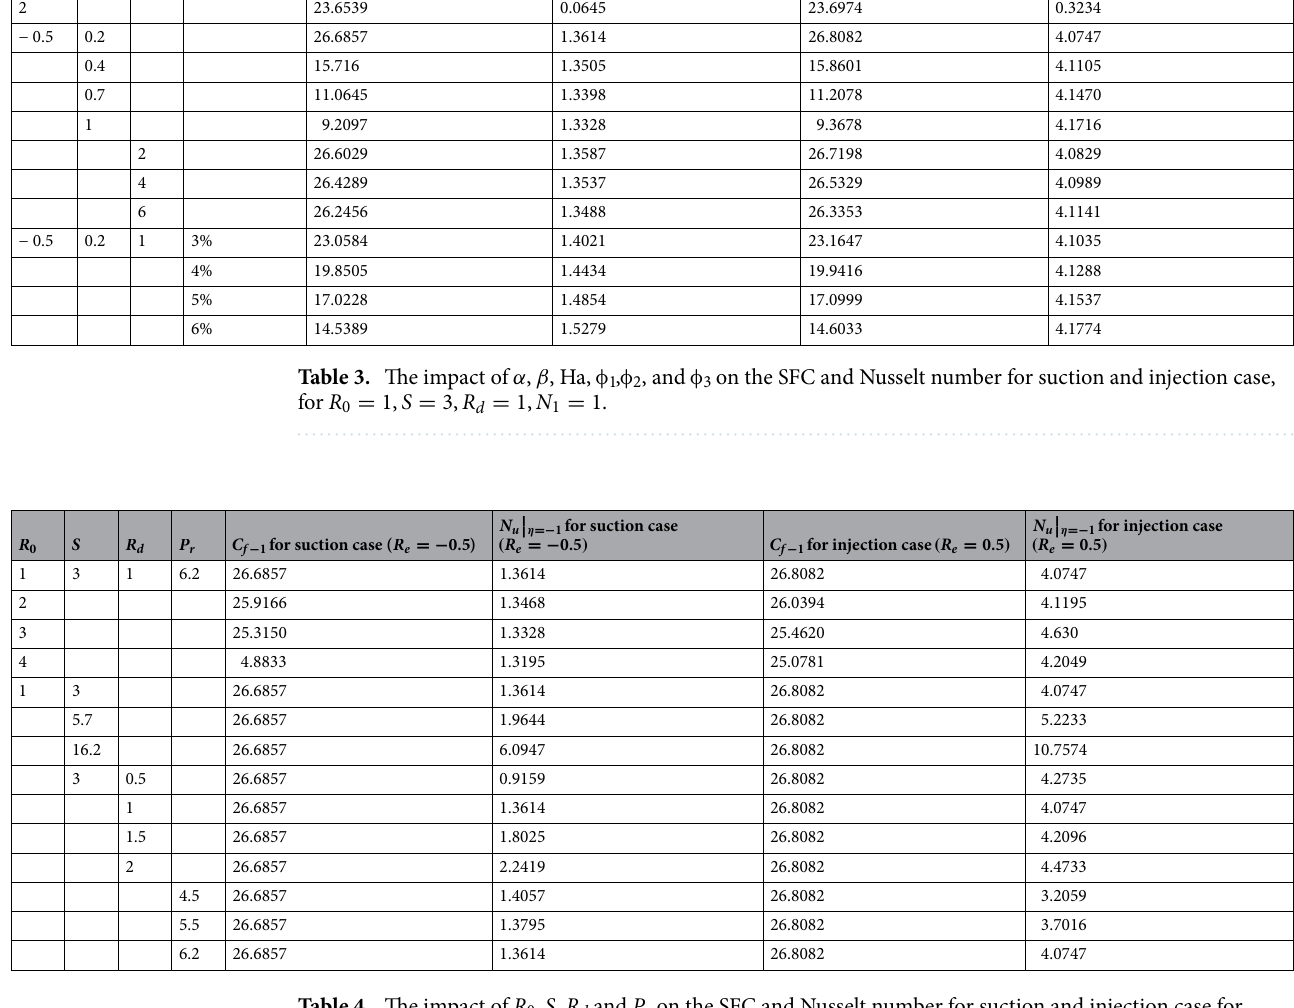
Table 4. The impact of R 0 , S , R d and P r on the SFC and Nusselt number for suction and injection case for